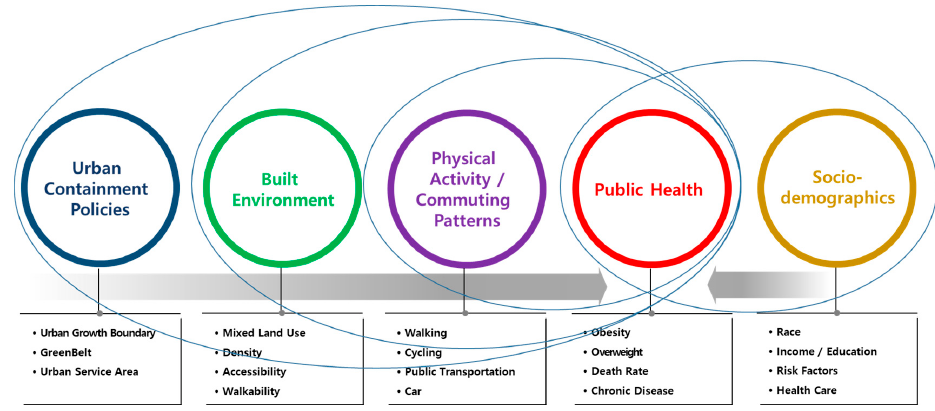
Figure 1. The relationship between urban containment policies and public health (Source: